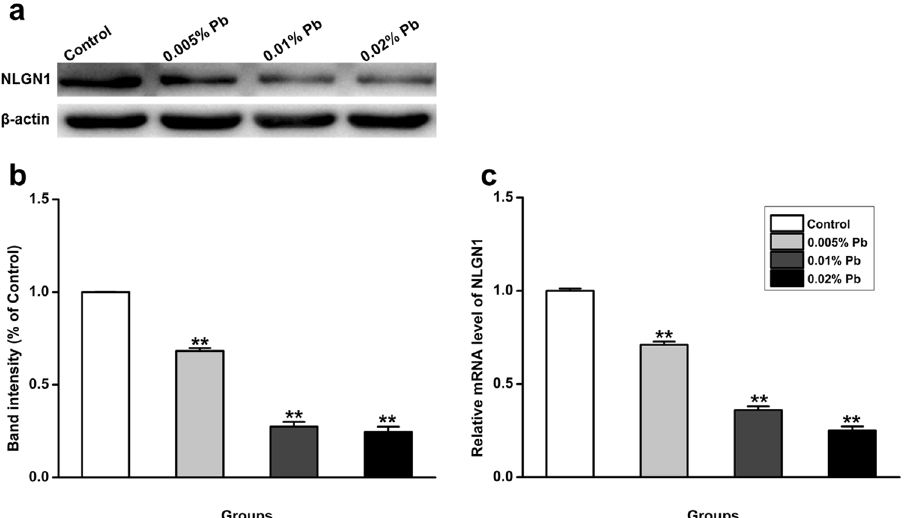
Figure 5. Effect of Pb exposure on NLGN1 transcript and protein expression in PND30 rats. ( a ) Protein expression of NLGN1 after Pb exposure was detected by western blotting. β -actin was detected as loading control. N = 8 per group. ( b ) Statistical analysis of the band intensity, which was measured as percentage of control. The protein level of NLGN1 is Pb dose-depended, negatively correlated with the Pb exposure levels. ( c ) NLGN1 mRNA expression was detected in the control group and Pb-exposed groups by qRT-PCR. The mRNA level of NLGN1 is Pb dose-depended, negatively correlated with the Pb exposure levels. N = 8 per group. Data are representative of at least three independently performed experiments and expressed as mean ± SD, ** p <